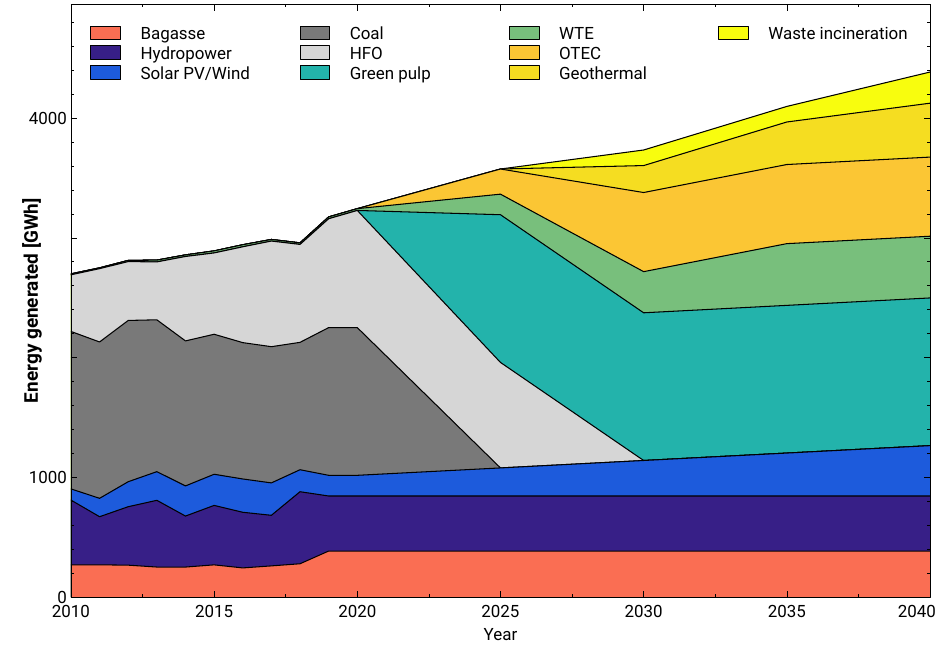
Figure 8. Electricity generation evolution of Reunion island from 2010 to